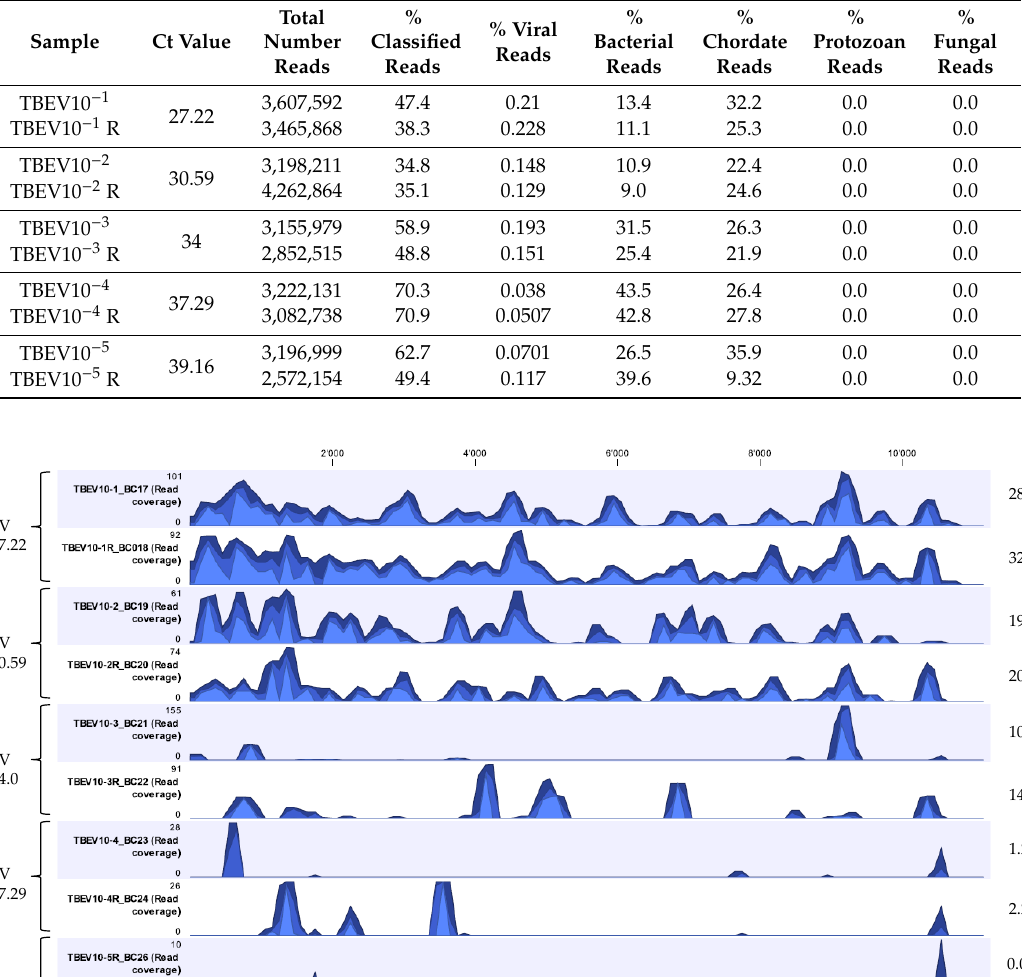
Table 5. Output of mNGS results for TBEV positive tick homogenates used for testing sensitivity of the sample preparation pipeline. Samples with “R” at the end are replicates. Ct: cycle threshold.